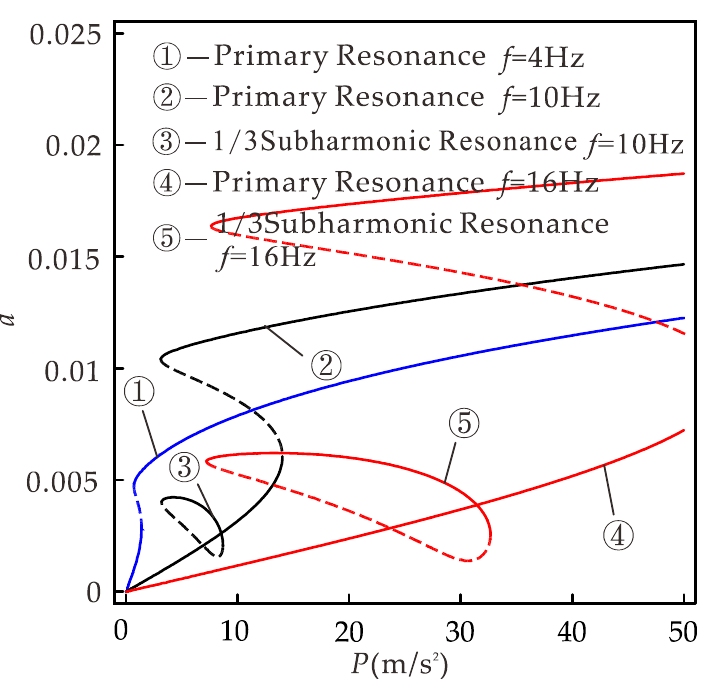
Figure 14. Amplitude versus excitation amplitude with different excitation frequencies.